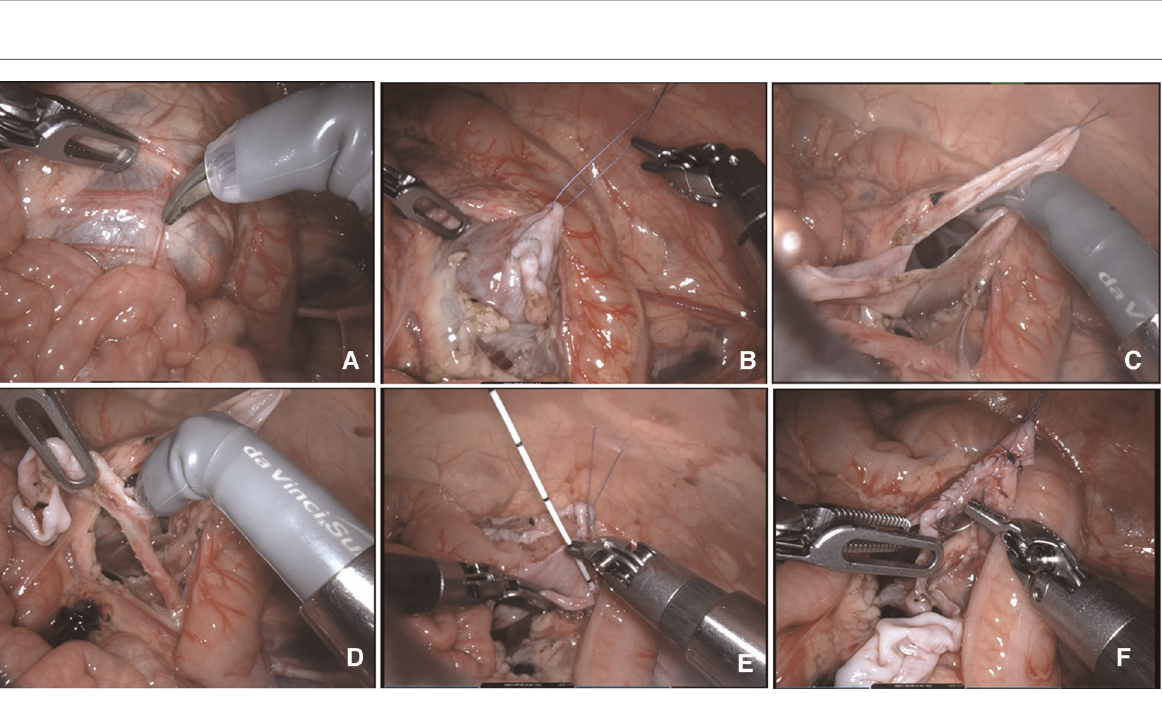
FIGURE 2 Surgical pyeloplasty procedures in the robotic groups. ( A ) The renal pelvis was identi fi ed by its dilation underneath the peritoneum. ( B ) A transabdominal hitch stitch was used to provide traction and facilitate exposure to the operative fi eld. ( C ) Incision of the dilated renal pelvis. ( D ) Lateral spatulation of the ureter. ( E ) Anastomotic suture and insertion of the JJ stent. ( F ) Suturing and anastomosis of the anterior